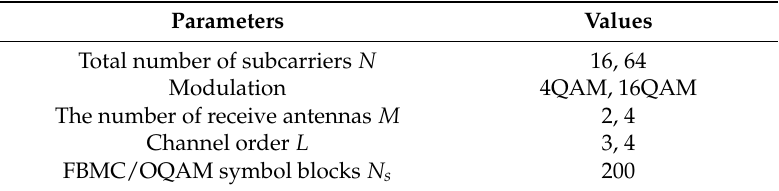
Table 1. Simulation